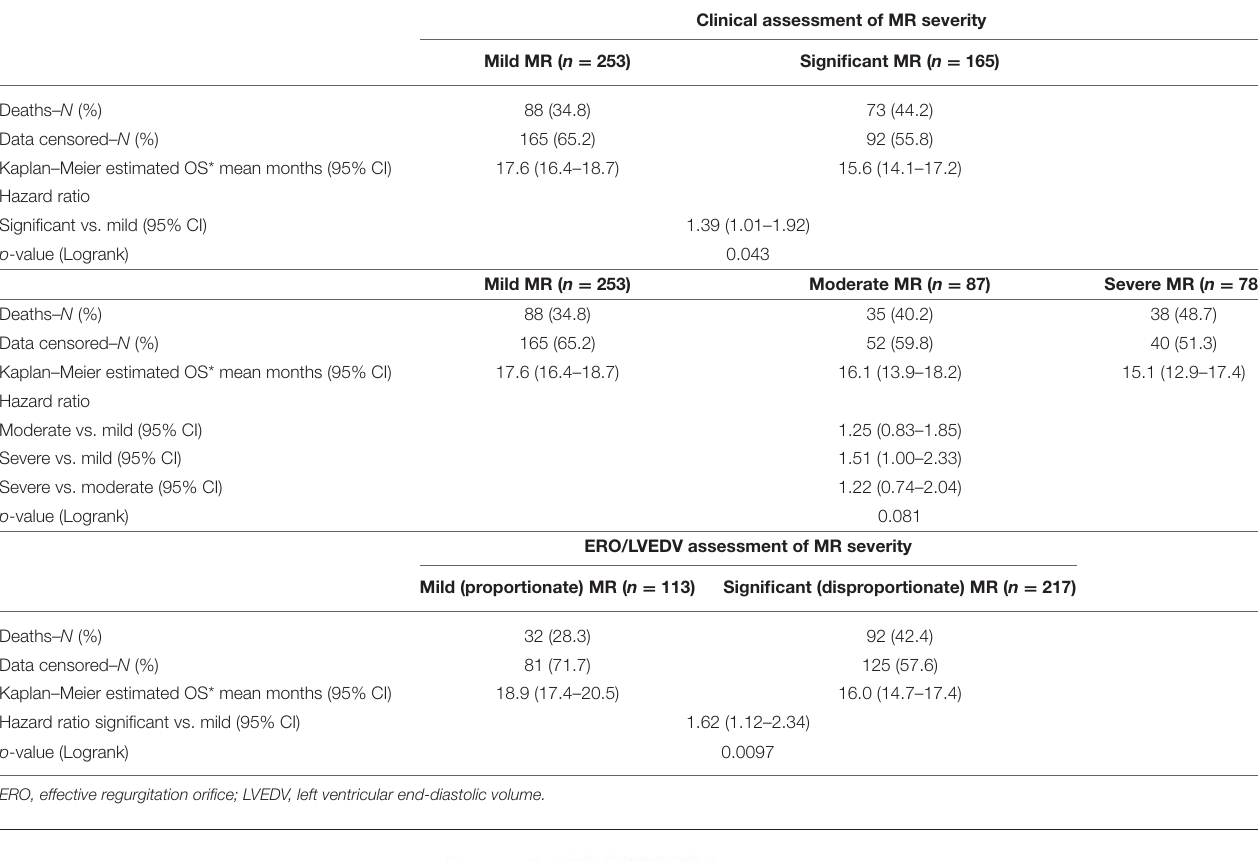
TABLE 5 | Kaplan–Meier estimates for overall survival at 24 months.